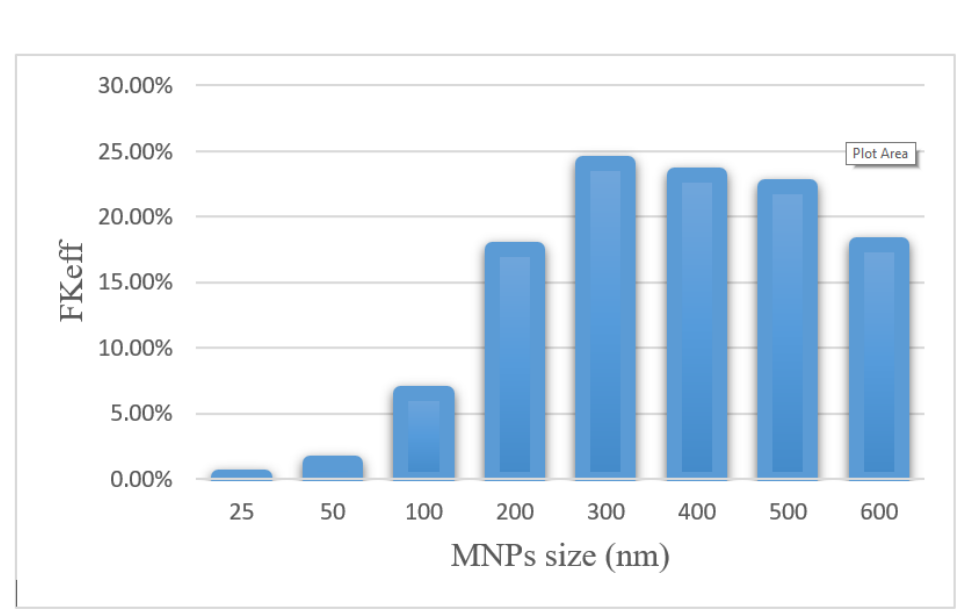
Figure 15. Comparison of FK eff for different sizes of MNPs after 60 min of treatment.